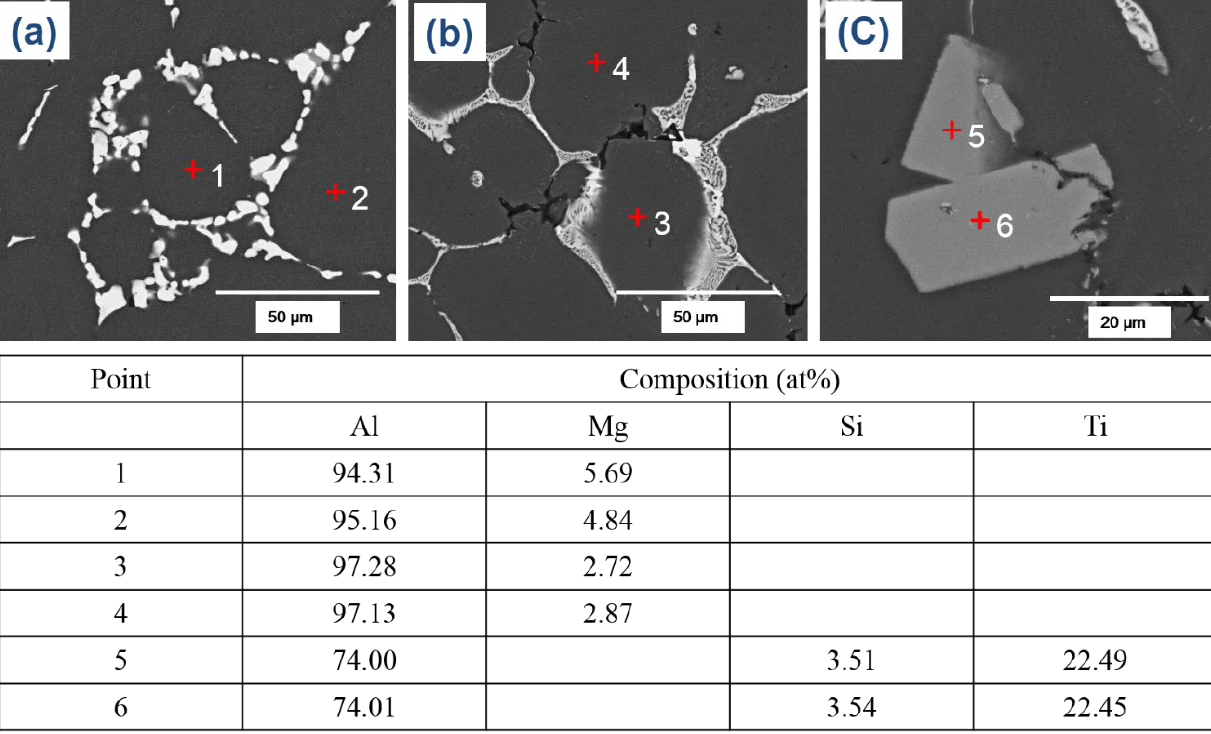
Figure 6. FE-SEM micrographs of ( a ) the B43 alloy and ( b , c ) the S43 alloy in their as-cast condition. The table below the micrographs provides the composition of the points indicated in the micrographs.